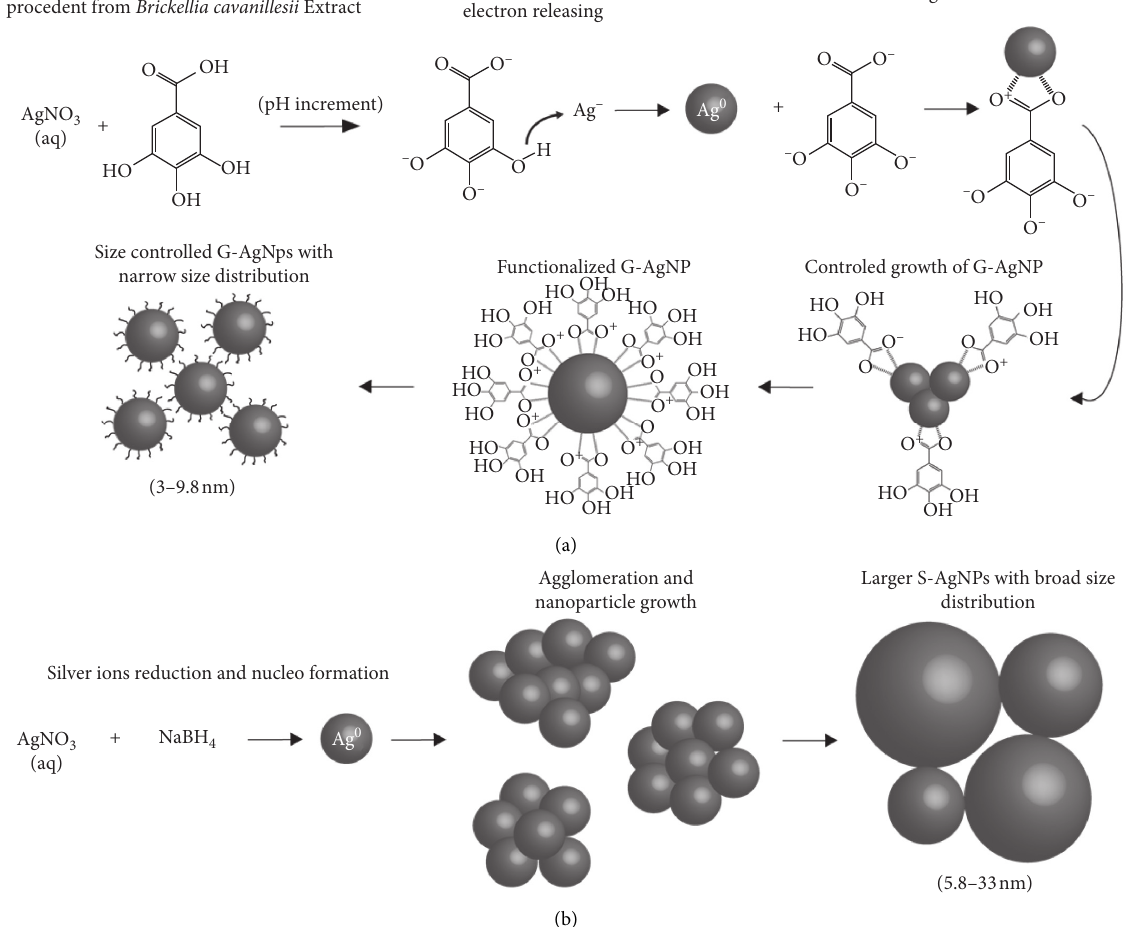
Figure 2: Schematic illustration showing: (a) synthesis and functionalization mechanism of G-AgNPs by tannins (simplified molecule) contained in Brickellia cavanillesii extract and particle size-control; (b) synthesis of S-AgNPs using NaBH4 and uncontrolled growth of the